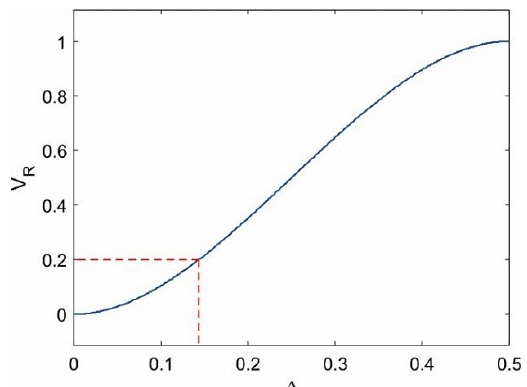
Figure 6. Ratio between volumes of cellular structure and solid structure.